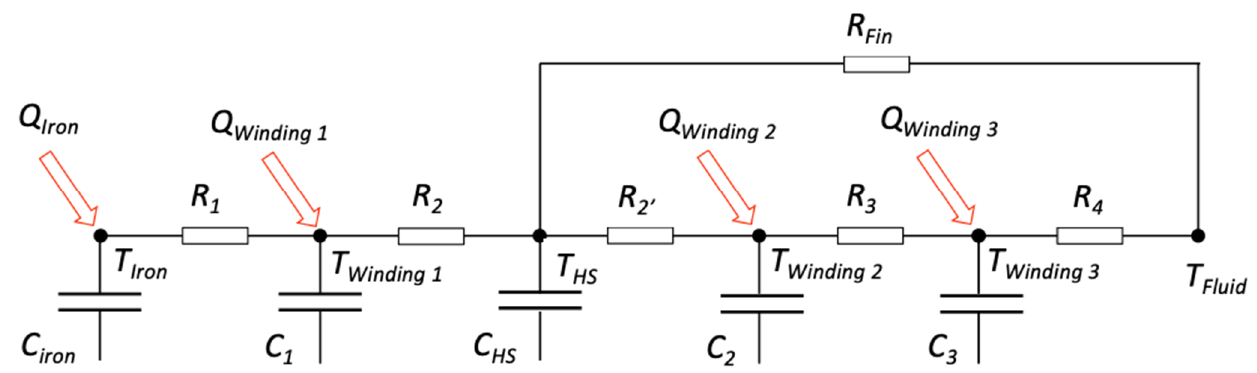
Figure 9. LP thermal model with a thermal node on each winding layer. The parameters Q iron and Q winding are the heat loads supplied to the iron and windings, respectively. C 1 –C 4 are the thermal capacity at each node. R 1 –R 3 are inter-layer thermal resistances. R 4 is the convective thermal resistance.